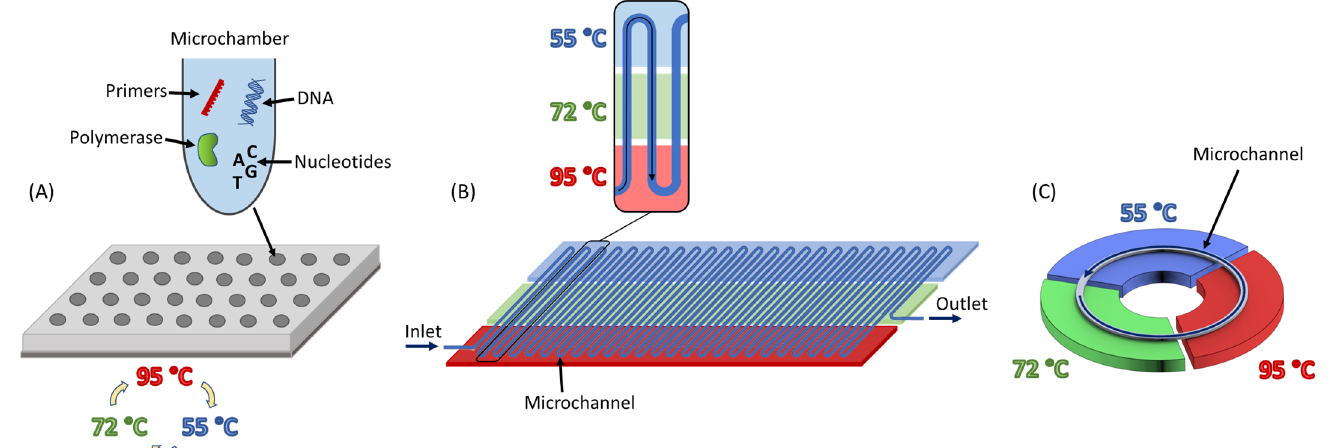
Figure 1. ( A ) Time-domain μ PCR. The PCR sample is placed inside microchambers where the temperature is cycled. ( B ) Space-domain, continuous-flow (CF) μ PCR. The sample is pumped through a microchannel, passing through zones of constant temperatures. ( C ) Space-domain closed-loop (CL) μ PCR. The sample flows through a circular microchannel, passing consecutively and repetitively through the different temperature zones.